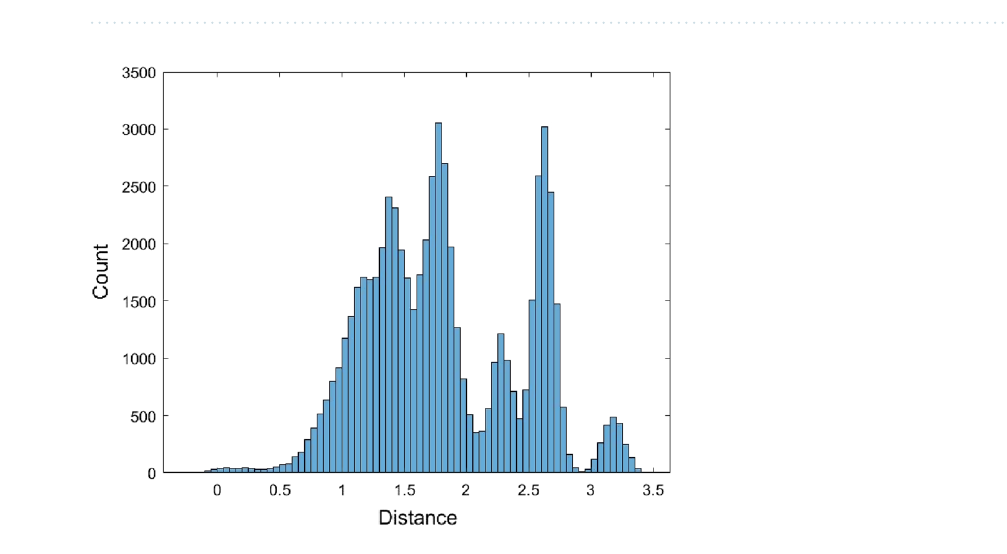
Figure 5. The histogram of 62,435 data generated from the fitted kernel density estimation method of the JC model distance data.